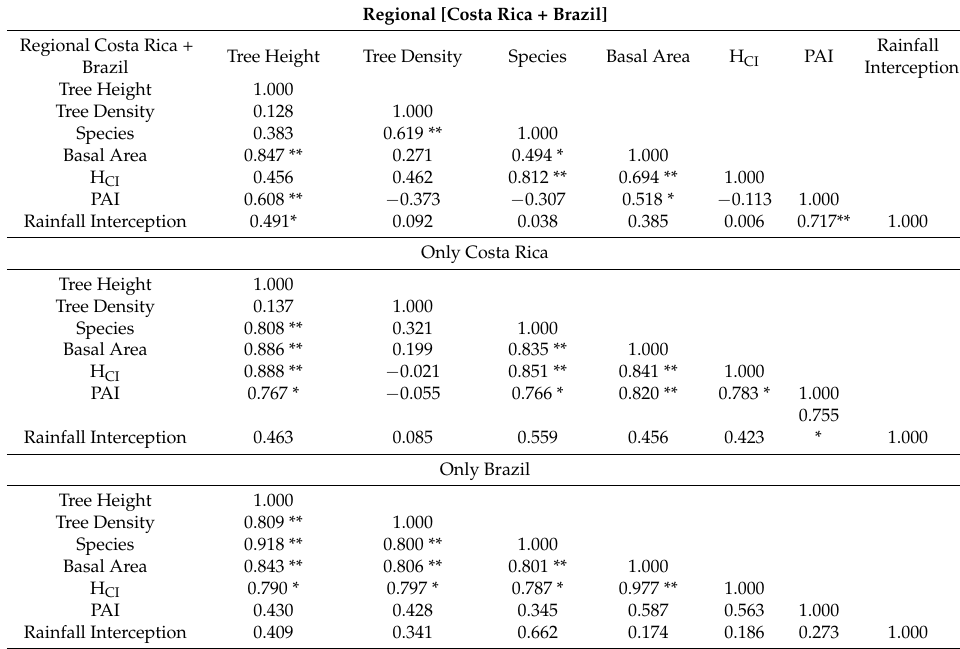
Table 5. Pearson correlation matrix among rainfall interception and structural variables in tropical dry forests (TDFs) in Costa Rica and Brazil. Regional [Costa Rica + Brazil] Regional Costa Rica + Tree Height Tree Density Species Basal Area H CI Brazil